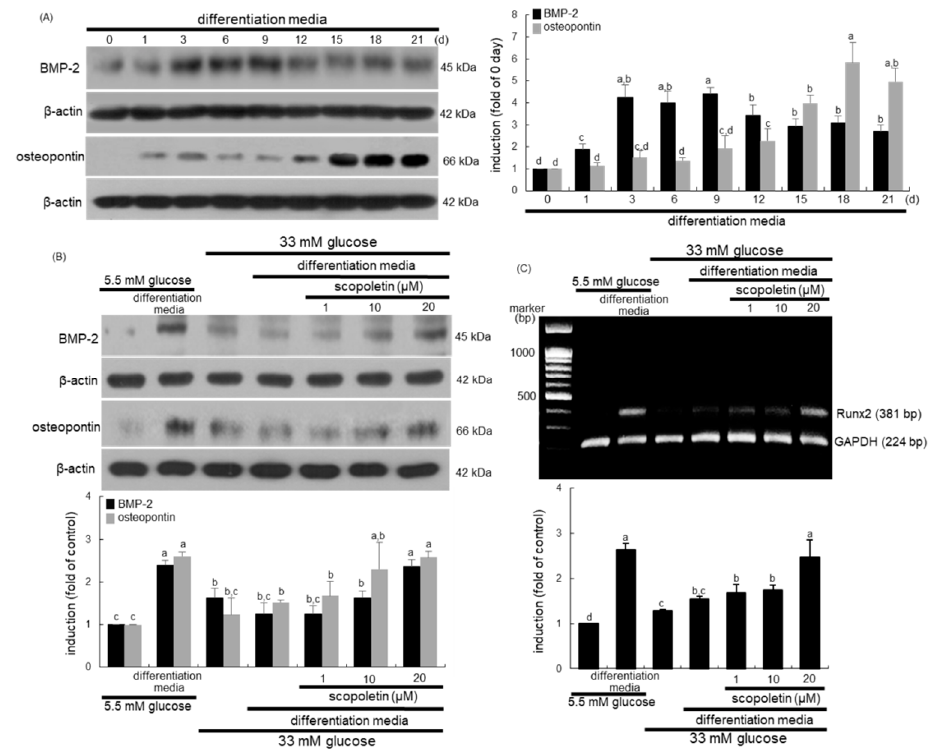
Figure 7. The temporal responses of induction of bone morphogenetic protein (BMP)-2 and osteopontin ( A ) and effects of scopoletin on induction of BMP-2 and osteopontin ( B ) and on Runt-related transcription factor 2 (Runx2) transcription ( C ) in pre-osteoblastic MC3T3-E1 cells. MC3T3-E1 cells were cultured in α -MEM-differentiation media for up to 21 days. Cell lysates were subject to Western blot analysis with a primary antibody against BMP-2 and osteopontin ( A , B ). β -Actin protein was used as an internal control. Values in bar graphs (mean ± SEM, n = 3) not sharing a small letter are different at p < 0.05. The transcription of Runx2 was measured by Reverse transcription polymerase chain reaction assay, and the glyceraldehyde 3-phosphate dehydrogenase (GAPDH) gene was used for the internal controls ( C ). Respective values (mean ± SEM, n = 3) not sharing a small letter are different at p <